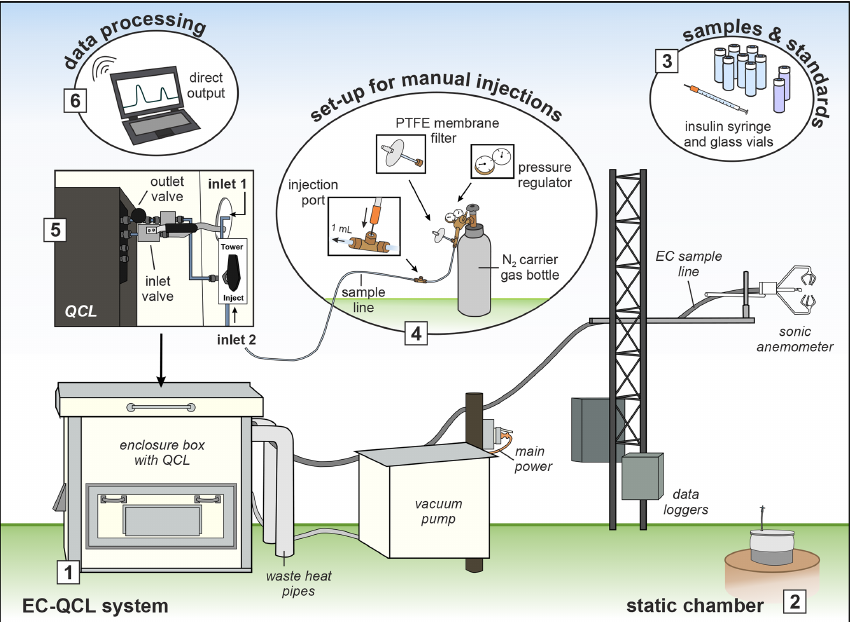
Figure 1. Schematic illustration of how to use a field-based QCL for EC measurements and manual injections. (1) The main components of the QCL EC system; (2) an example of a static chamber from which N 2 O samples were taken and stored in (3) pre-evacuated glass vials. Once the set-up for manual injections (4) was assembled and the QCL air inlet (5) adjusted from drawing ambient air through the EC sample line (inlet 1) to drawing air via the injection tube (inlet 2), the QCL was readily set up to receive injections of N 2 O samples and associated standards through the injection port. The data output (6) was immediate, allowing processing and data evaluation on the day of chamber